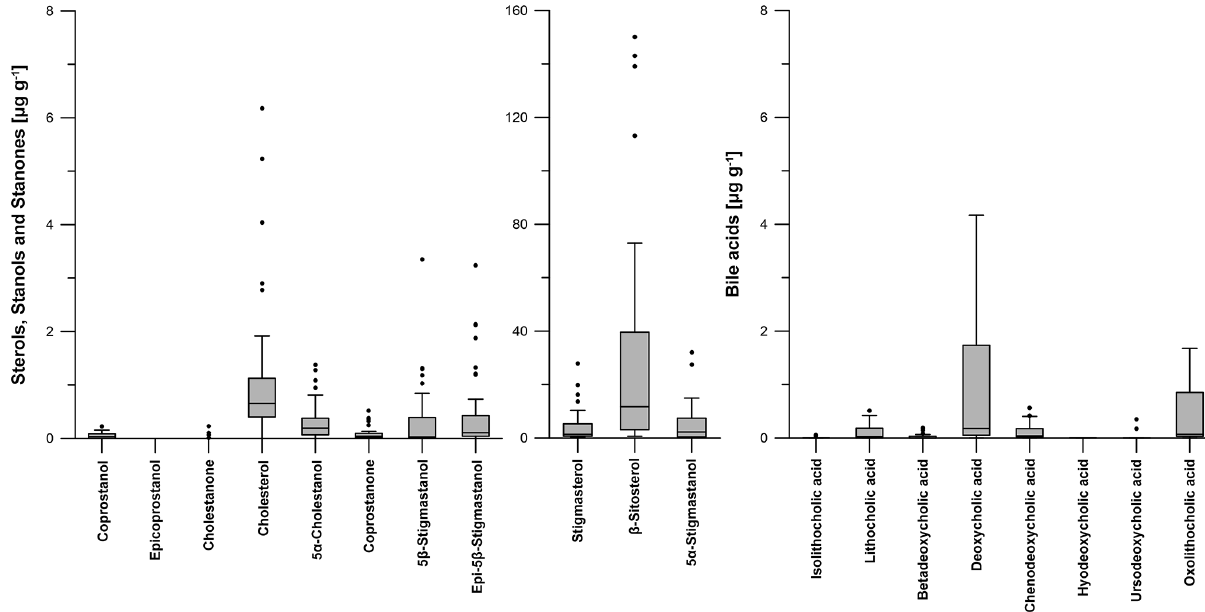
Figure 6. Boxplots visualizing the content (in micrograms per gram of dry matter) of steroid (sterols, stanols, stanones and bile acids) patterns for all soil samples from the prehistorical encampment site of Ullafelsen in the Fotsch Valley, Stubai Alps, Austria. For a better overview, the steroids stigmastanol, β -sitosterol and 5 α -stigmastanol were plotted on a separate y axis because of their high contents.